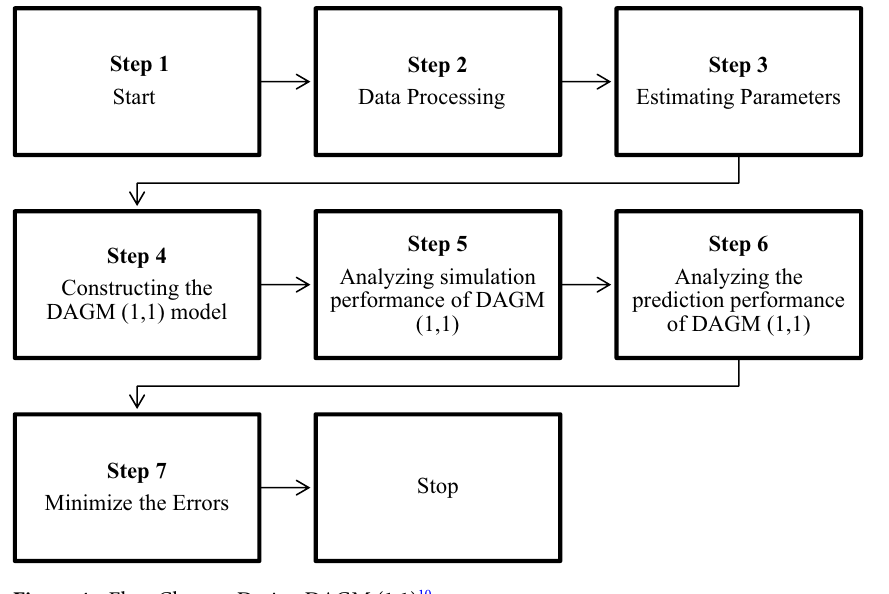
Figure 4. Flow Chart to Design DAGM (1,1) 10